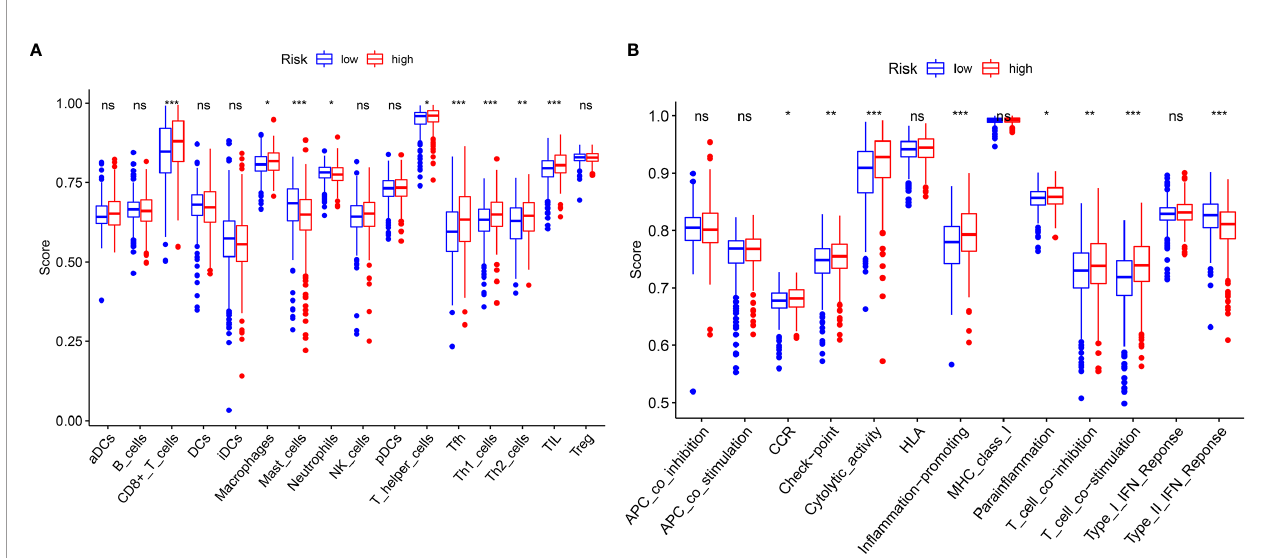
FIGURE 5 | ssGSEA analysis of FeSig. (A, B) The ssGSEA score of 16 immune cells and 13 immune-related functions between high-risk group and low-risk group. ssGSEA, single sample gene set enrichment analysis. ***P < 0.001; **P < 0.01; *P < 0.05; ns, no signi fi